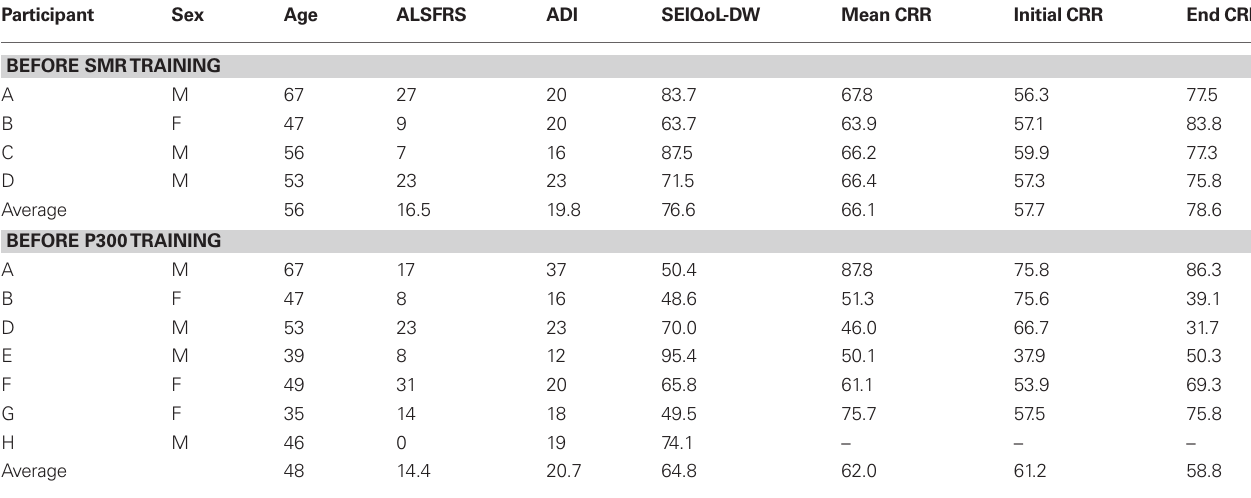
Table 3 | Overview of physical and psychological parameters and the average BCI performance over all sessions (mean CRR or mean CSC), over the first three sessions (initial CRR or CSC) and over the last three sessions (end CRR or CSC).